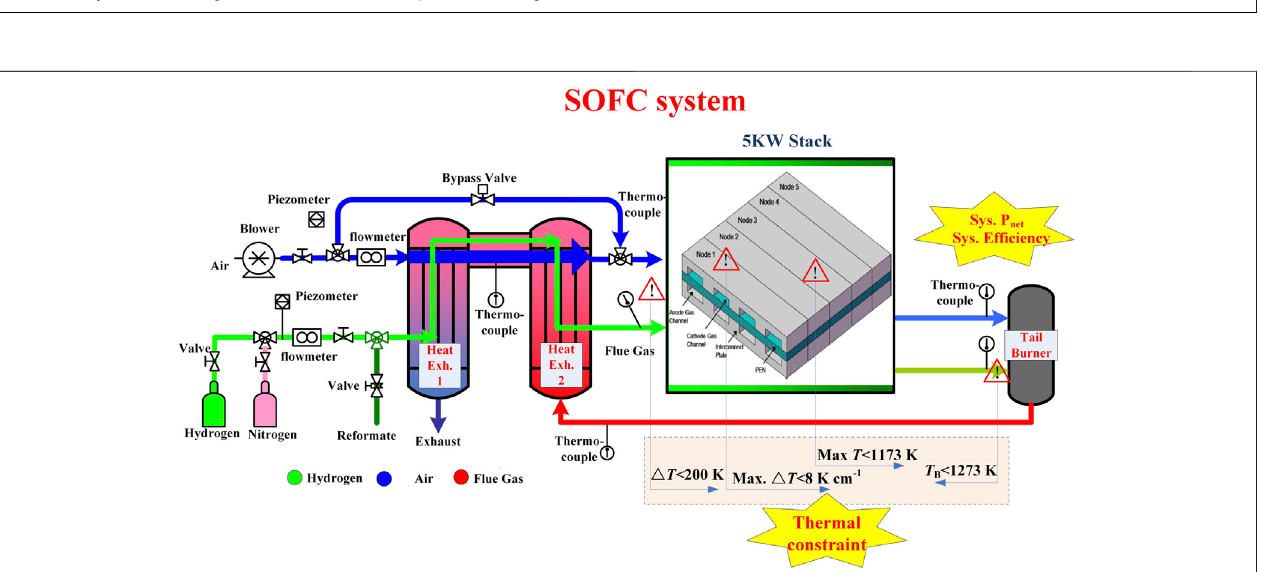
FIGURE 1 | Schematic diagram of the SOFC-based hybrid DC microgrid.